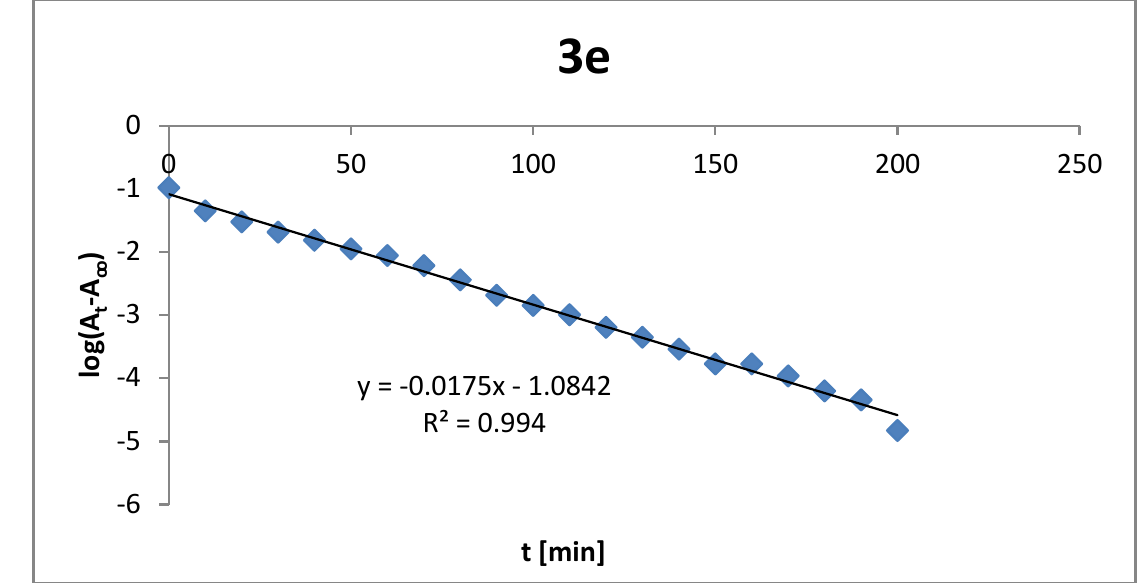
Figure 7. Semilogarithmic plots used to determine rate constants for spontaneous hydrolysis of compound 3e .